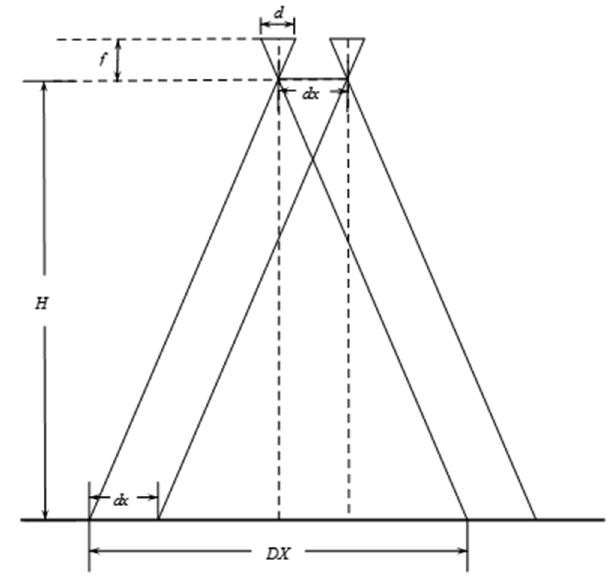
Figure 2. Schematic diagram of two camera